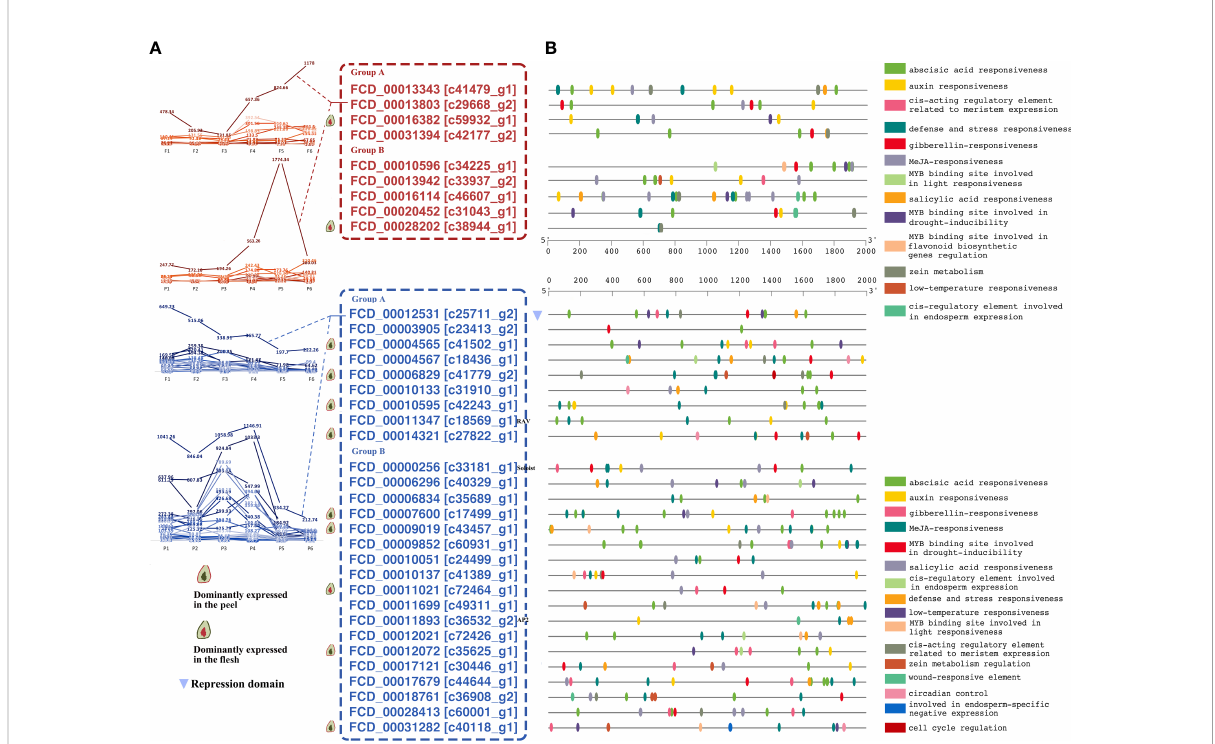
FIGURE 6 FcAP2/ERF genes signi fi cantly correlated with fruit ripening and analysis of their promoter regions. The thresholds used were FPKM ≥ 20 in at least one sample and the sum of expression values on days four through six divided by the sum of expression values on days one through three > 2 or < 0.5. (A) FcAP2/ERF genes positively or negatively correlated with fruit ripening. (B) Promoter region analysis of FcAP2/ERF genes signi fi cantly correlated with fruit